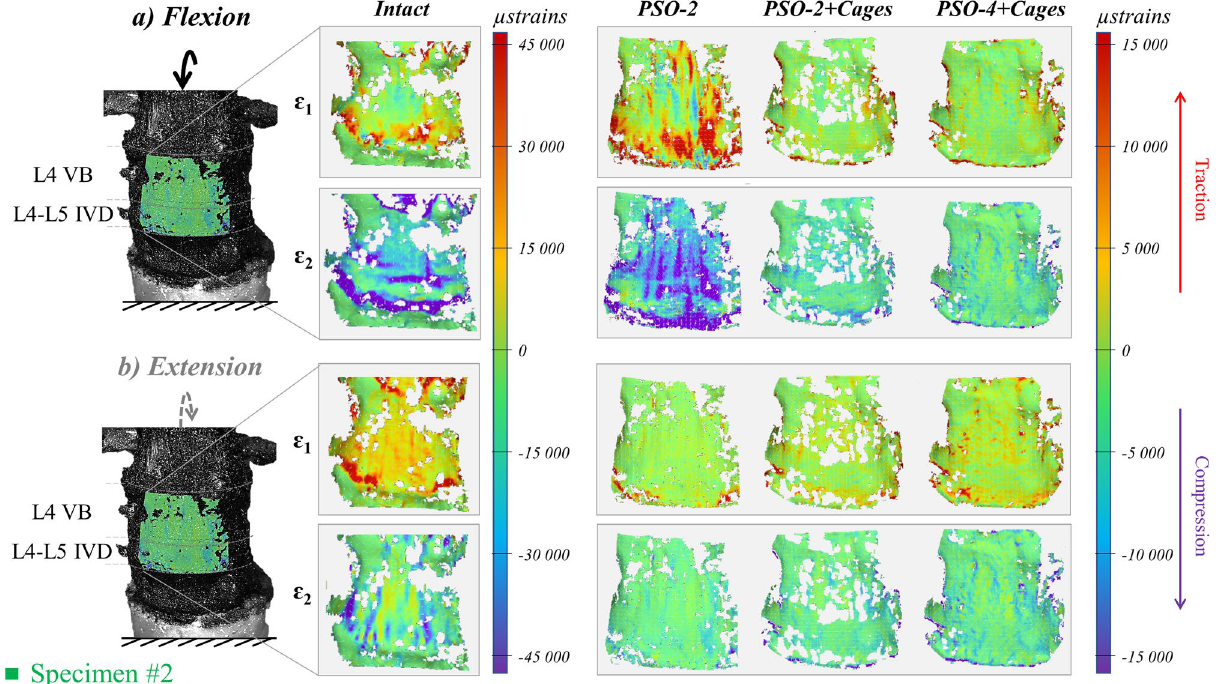
Figure 3. Flexion ( a ) and extension ( b ): tensile (ε 1 ) and compressive (ε 2 ) strain maps measured on the “Intact” condition and following PSO at L4 and posterior instrumentation with 2 primary-rods (“PSO-2”), with 2 rods and supplementary intervertebral cages (“PSO-2 + Cages”), and with supplementary accessory rods and intervertebral cages (“PSO-4 + Cages”). A picture of the specimen with the correlated areas are reported on the left, indicating the treated level (L4) and the caudal IVD. A representative specimen (#2) is shown here (strain maps for every specimen provided as Supplementary Figures). The DIC strain maps have been obtained using the proprietary software Istra 4D (v4.3.1, Dantec Dynamics, Denmark; URL: https ://www.dante cdyna mics. Flexion. In the intact condition, compressive strains were directed in axial direction (Fig. 3a) and they were higher on the L4-L5 IVD (− 23,000 µstrains), while being lower on the L4 VB (− 15,300 µstrains); tensile strains were directed transversally and they were comparable on the IVD (18,600 µstrains), but much lower on the VB (4400 µstrains). Following PSO, median tensile and compressive strains significantly decreased compared to the intact condition (p = 0.014), respectively, to 30% and 16% on the VB, and to 12% and 10% on the IVD (Fig. 4a,b). No significant differences were noticed among different instrumentation steps. The posterior side of the primary rods underwent longitudinal tension, with median rod strains being the highest (400 µstrains) for simple bilateral stabilization. Strains normalized to “PSO-2” decreased to 81% after cage insertion and to 50% with supplemental accessory rods (Fig. 4c,d). Significant variations were found for “PSO-4 + Cages” compared to “PSO-2” (p = 0.004). Extension. In the intact condition, tensile strains were directed axially (Figs. 3.b) on the L4-L5 IVD (21,000 µstrains), while they were lower on the L4 VB (11,800 µstrains); transverse compressive strains were comparable on the VB (− 10,500 µstrains), but much lower on the IVD (− 8300 µstrains). Following PSO, median tensile and compressive strains significantly decreased compared to the intact condition (p = 0.037), respectively, to 17% and 10% at PSO level, and to 9% and 17% on the IVD (Fig. 4a,b). No significant differences were noticed among different instrumentation steps. The posterior side of the primary rods underwent longitudinal compression, with median strains being lower than in flexion (110 µstrains) for simple bilateral stabilization. Normalized strains decreased to 88% after cage insertion and to 60% with supplemental accessory rods (Fig. 4c,d). Significant variations were found for “PSO-4 + Cages” compared to “PSO-2” (p = 0.011). Lateral bending. In the intact condition, the median tensile and compressive strains were both comparable on the IVD (12,000 vs. − 11,000 µstrains) and higher than on the VB (5400 vs. − 7700 µstrains). Specimens under- went axial compression on the ipsilateral side with circumferential stretching on the IVD (Fig. 5), while the contralateral side underwent axial stretching and circumferential compression. Following PSO, ipsilateral tensile and compressive strains significantly decreased compared to the intact condition (p ≤ 0.002), respectively, to 18% and 13% at PSO level, and to about 17% and 15% on the IVD (Fig. 6a–d). On the contralateral side, tensile and compressive strains decreased to 14% and 29% at PSO level, and to about 17% and 20% on the IVD. Variations